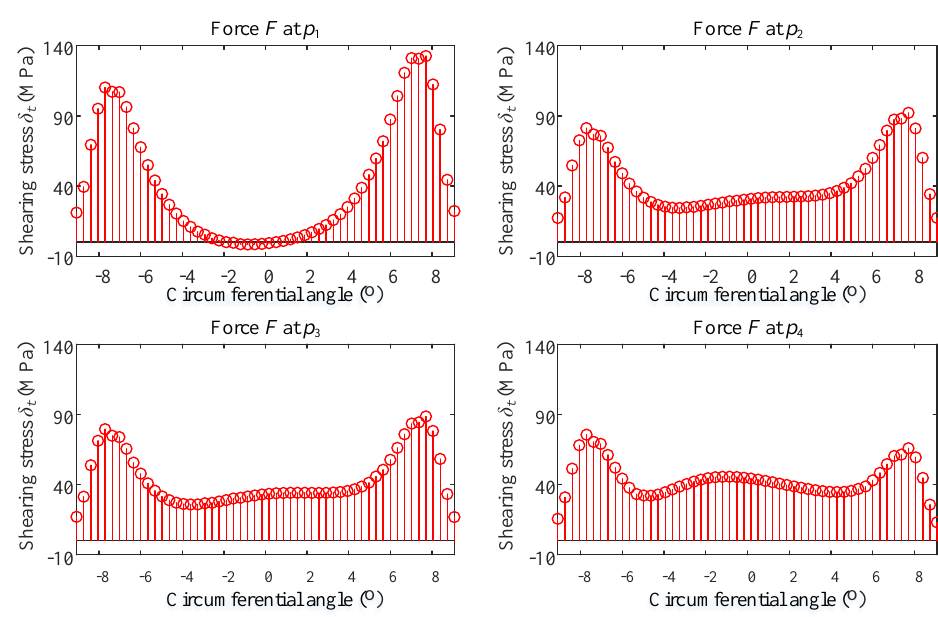
Figure 7. Effect of loading locations on tooth root normal stress.